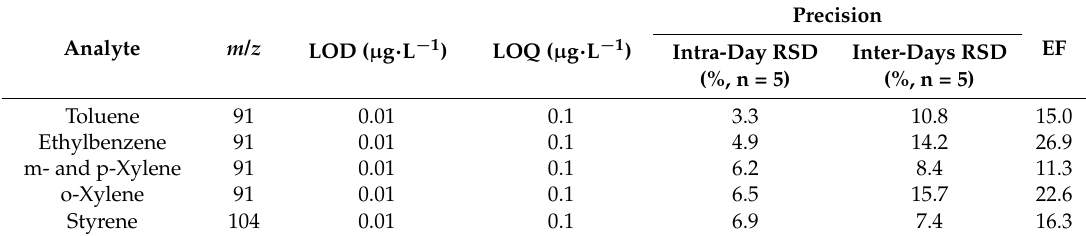
Table 3. Analytical figures of merit of macroscopic 3D SWNHs monoliths for the determination of the target